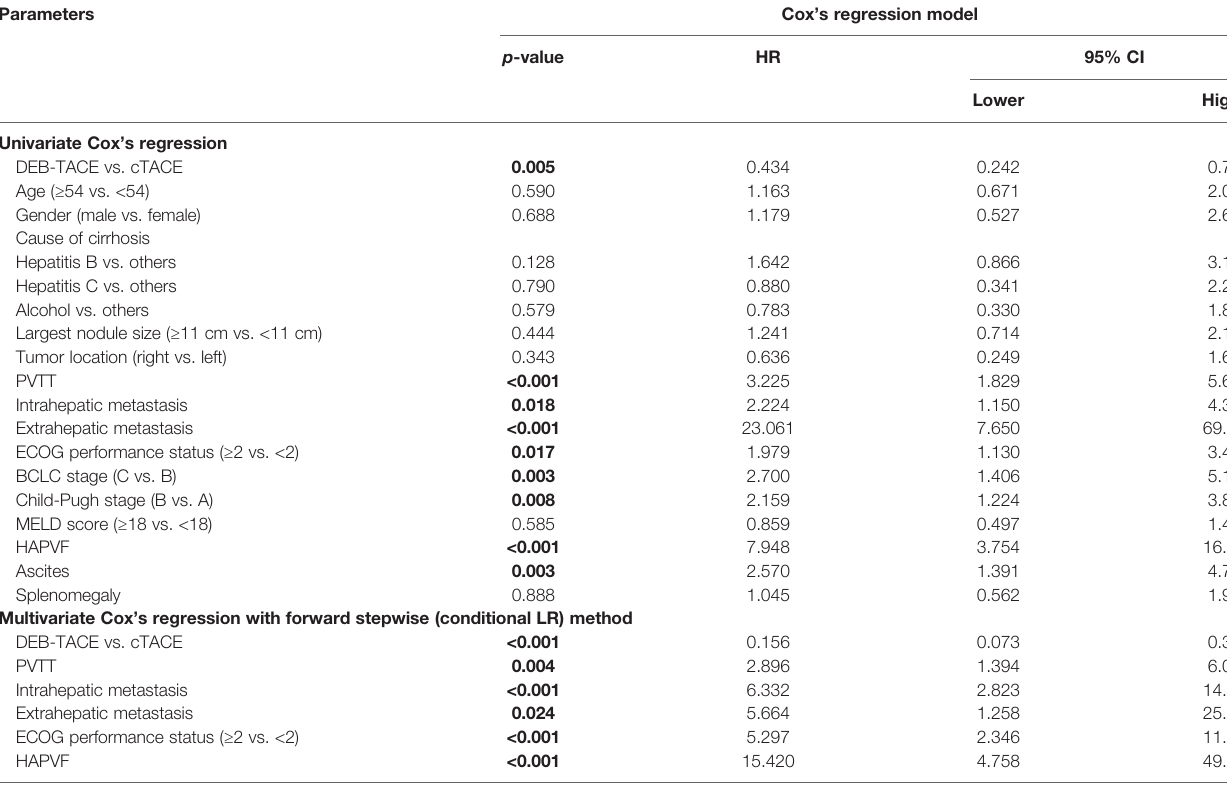
TABLE 3 | Factors affecting OS by Cox ’ s proportional hazards regression model analysis. Parameters